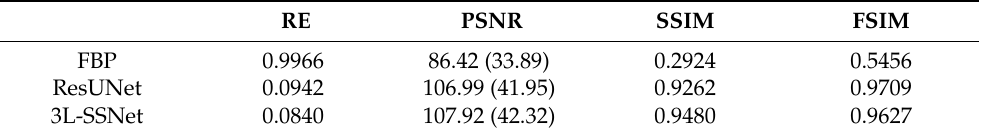
Table 3. The average of the full-reference metrics on the test set in the case of half-range geometry. RE PSNR SSIM FSIM FBP 0.9932 86.45 (33.90) 0.2962 0.6819 ResUNet 0.1016 106.38 (41.71) 0.9324 0.9478 3L-SSNet 0.1309 104.34 (40.91) 0.9021